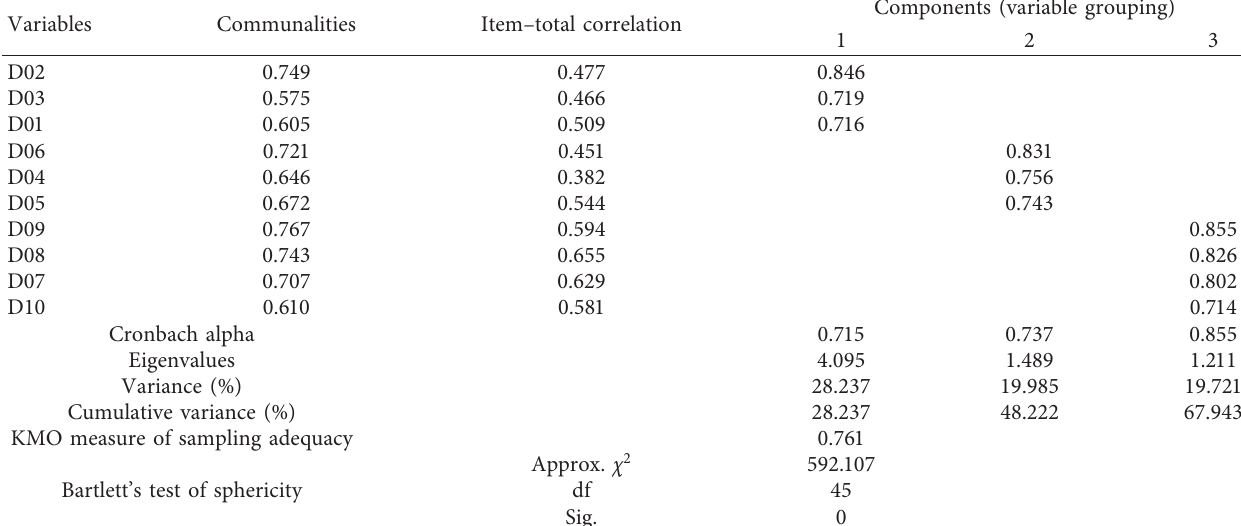
Table 6: Results of the factor analysis for external variables.